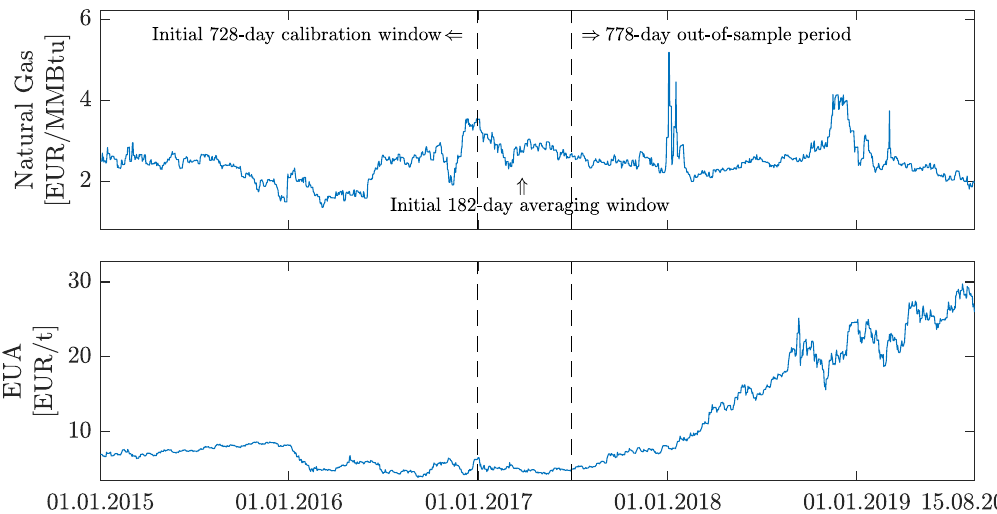
Figure 2. Hourly consumption prognosis ( top ), wind ( middle ) and solar ( bottom ) hourly generation forecasts. Data span from 1 January 2015 to 15 August 2019. Note that for each series plot, the limits on the y axes are differ. The first vertical dashed line marks the end of the 728-day calibration period and the second marks the end of the initial 182-day calibration window for averaging forecasts.